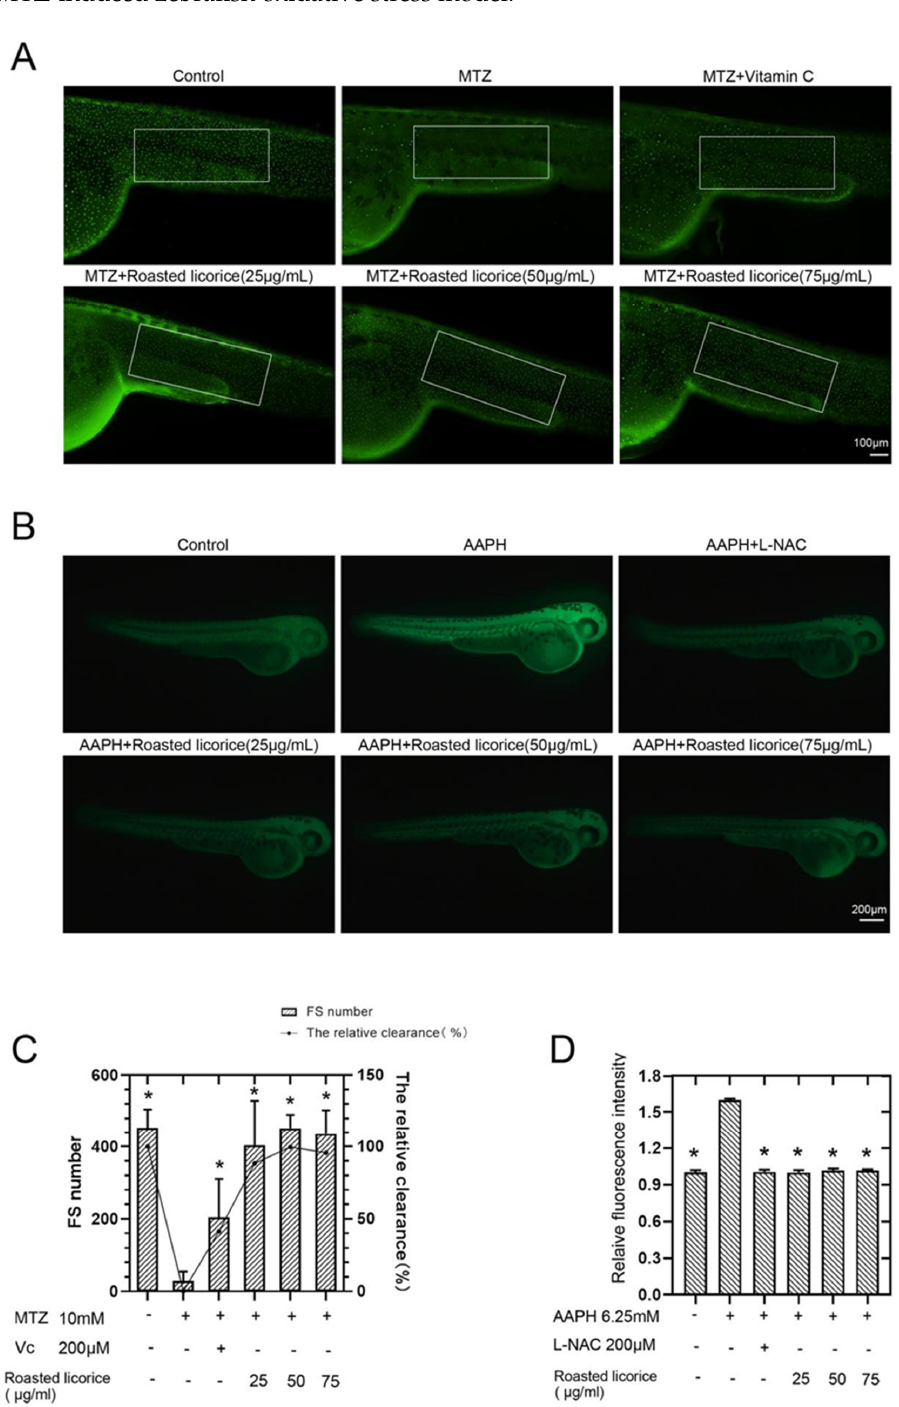
Figure 1. Antioxidant activities of roasted licorice extracts in zebrafish: ( A ) In vivo visualization of zebrafish skin fluorescence of drug treatment in transgenic zebrafish embryos; ( B ) in vivo visualization of ROS level of drug treatment in wild-type AB zebrafish embryos; ( C ) statistical results of fluorescence spots (FS) and the antioxidant activity of transgenic zebrafish in ( A ). The white enclosed area is the statistical range of zebrafish skin fluorescent spots; ( D ) statistical results of fluorescence intensity of wild-type AB zebrafish in ( B ). * Significant difference as compared with the MTZ or AAPH treatment group, p < 0.05 ( n =